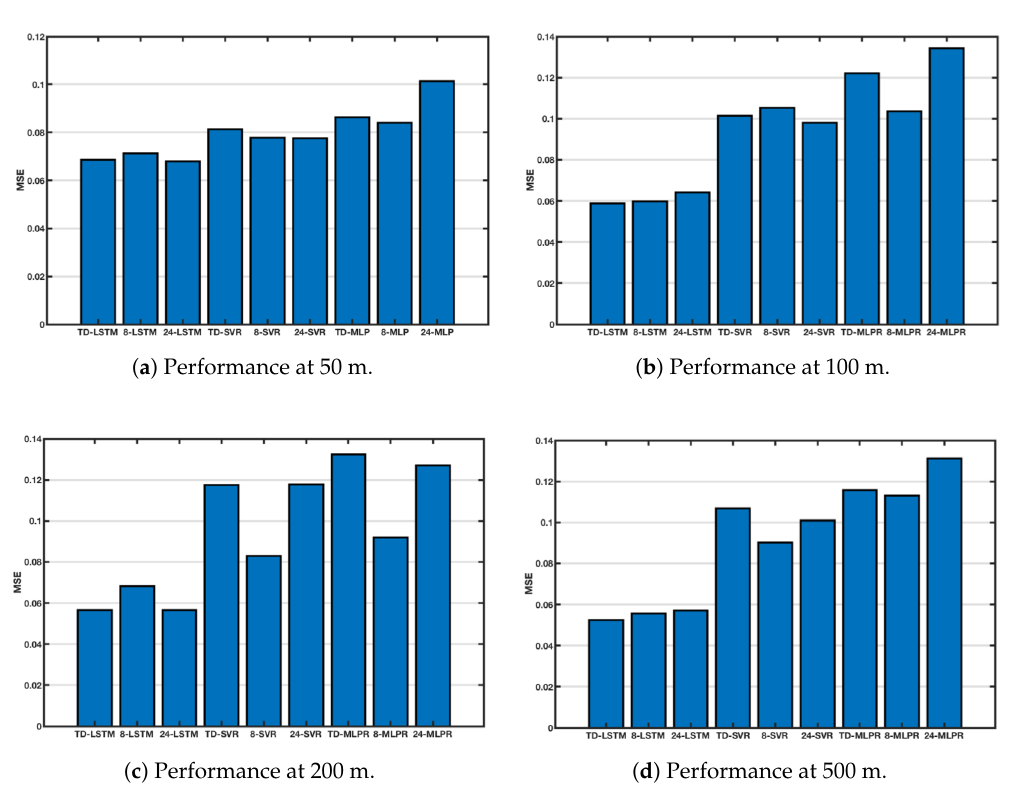
Figure 6. Comparison of performance at different depths.